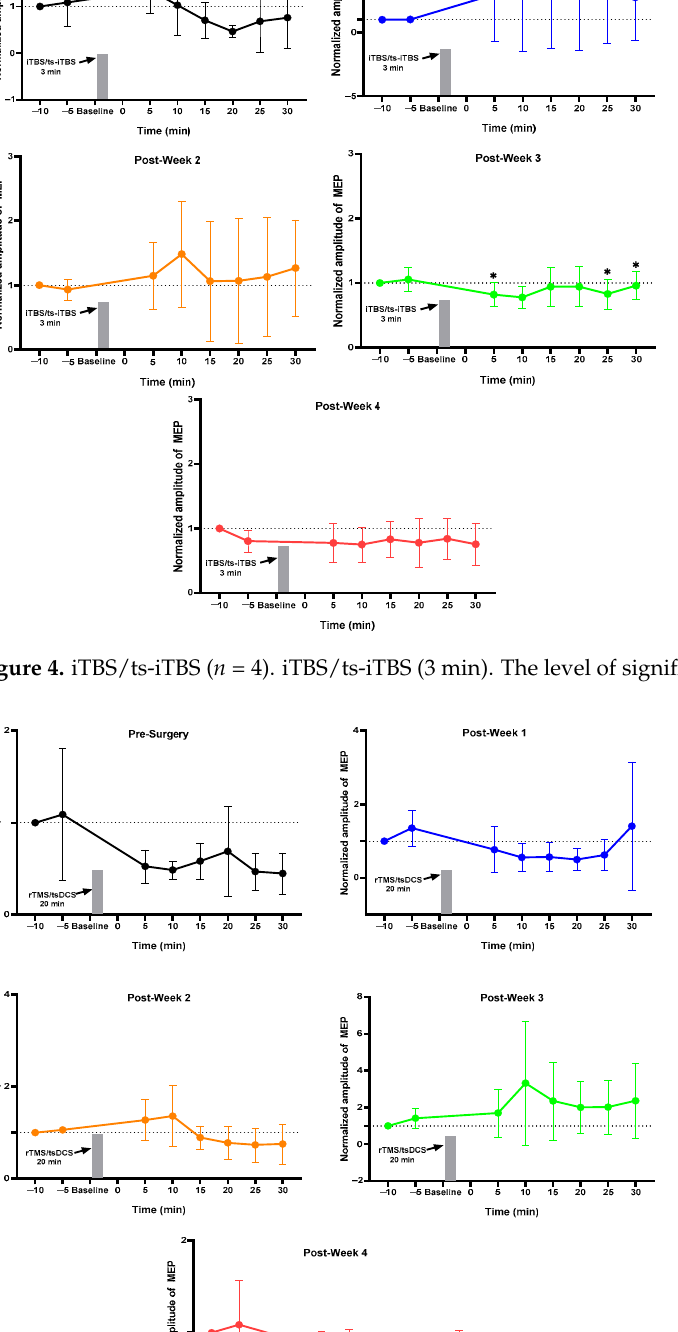
Figure 3. iTBS/tsDCS ( n = 4). iTBS/tsDCS (3 min). The level of significance was set to p < 0.050 *.